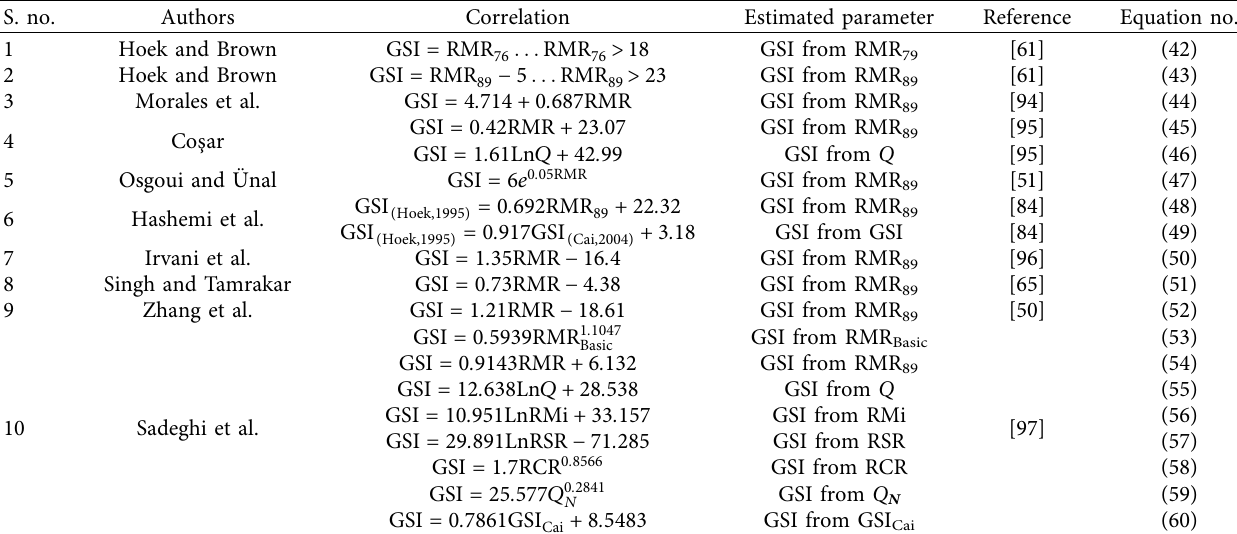
Table 3: Comparison of various correlations among the rock mass classifications. Correlation Estimated parameter Reference Equation no.